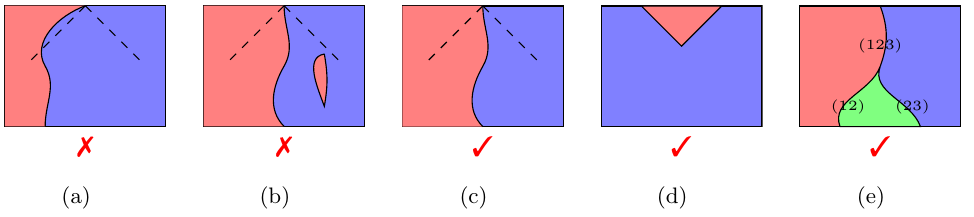
Figure 13 . Domain wall rules: (a) domain wall must not go outside the light cone. (b) \bubble" is forbidden. (c) legitimate con(cid:12)guration: an elementary domain wall travel inside the light cone. (d) legitimate con(cid:12)guration: two domain walls meet and annihilate. (3) domain wall split according to multiplication